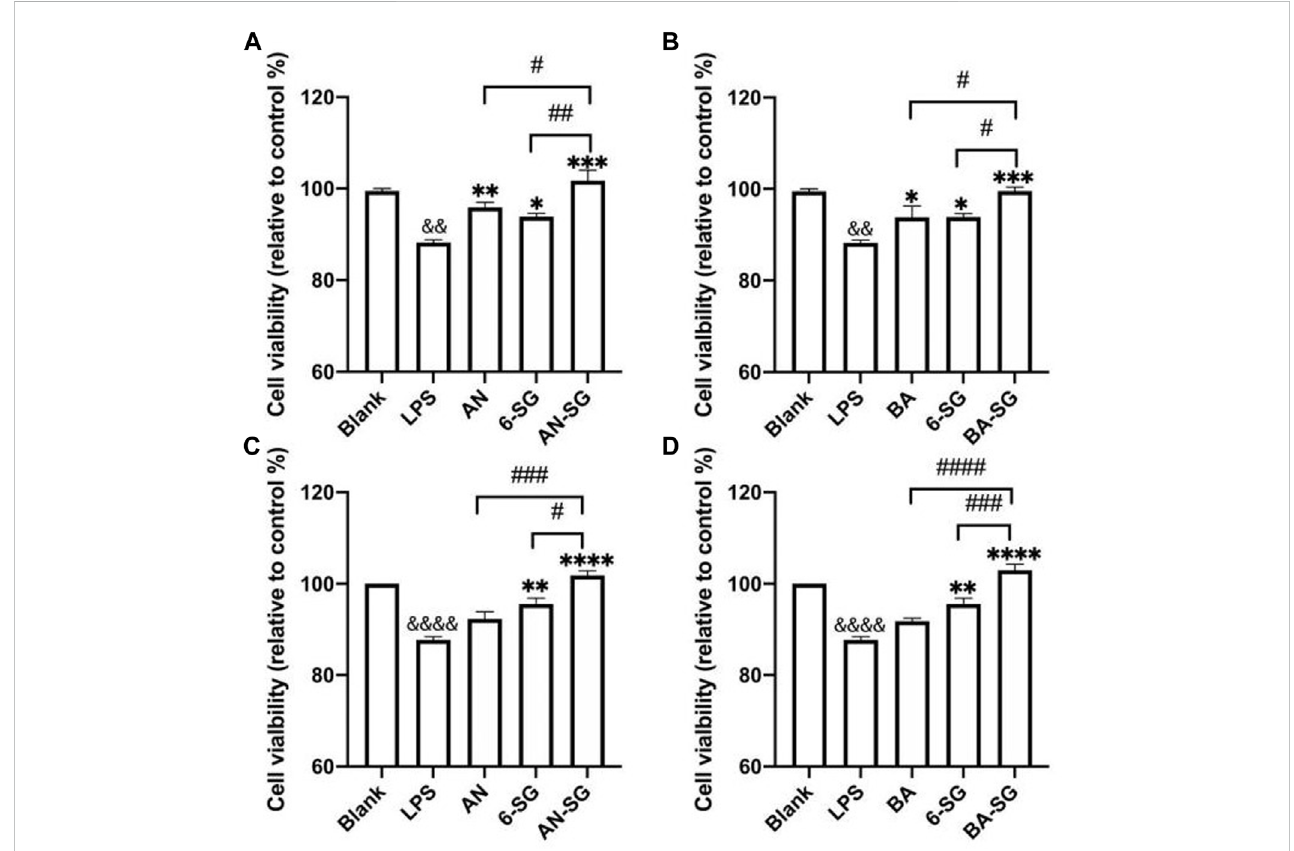
AN-SG and BA-SG exhibited greater restored cell viability in N2A cells of the tri-culture system against the LPS stimulation compared with their correspondingindividualcomponent.TheAlamarblueassaywasevaluatedfor (A) AN-SGand (B) BA-SG,andtheMTTassayon (C) AN-SGand (D) BA-SG.Data are shown as mean ± SEM ( n > 3). && p < 0.01, &&&& p < 0.0001 vs. Blank, * p < 0.05, ** p < 0.01, *** p < 0.001, **** p < 0.0001 vs. LPS, # p < 0.05, ## p < 0.01, ### p < 0.001, #### p < 0.0001 vs. combination, by one-way ANOVA analysis and Tukey test for group comparison in GraphPad Prism